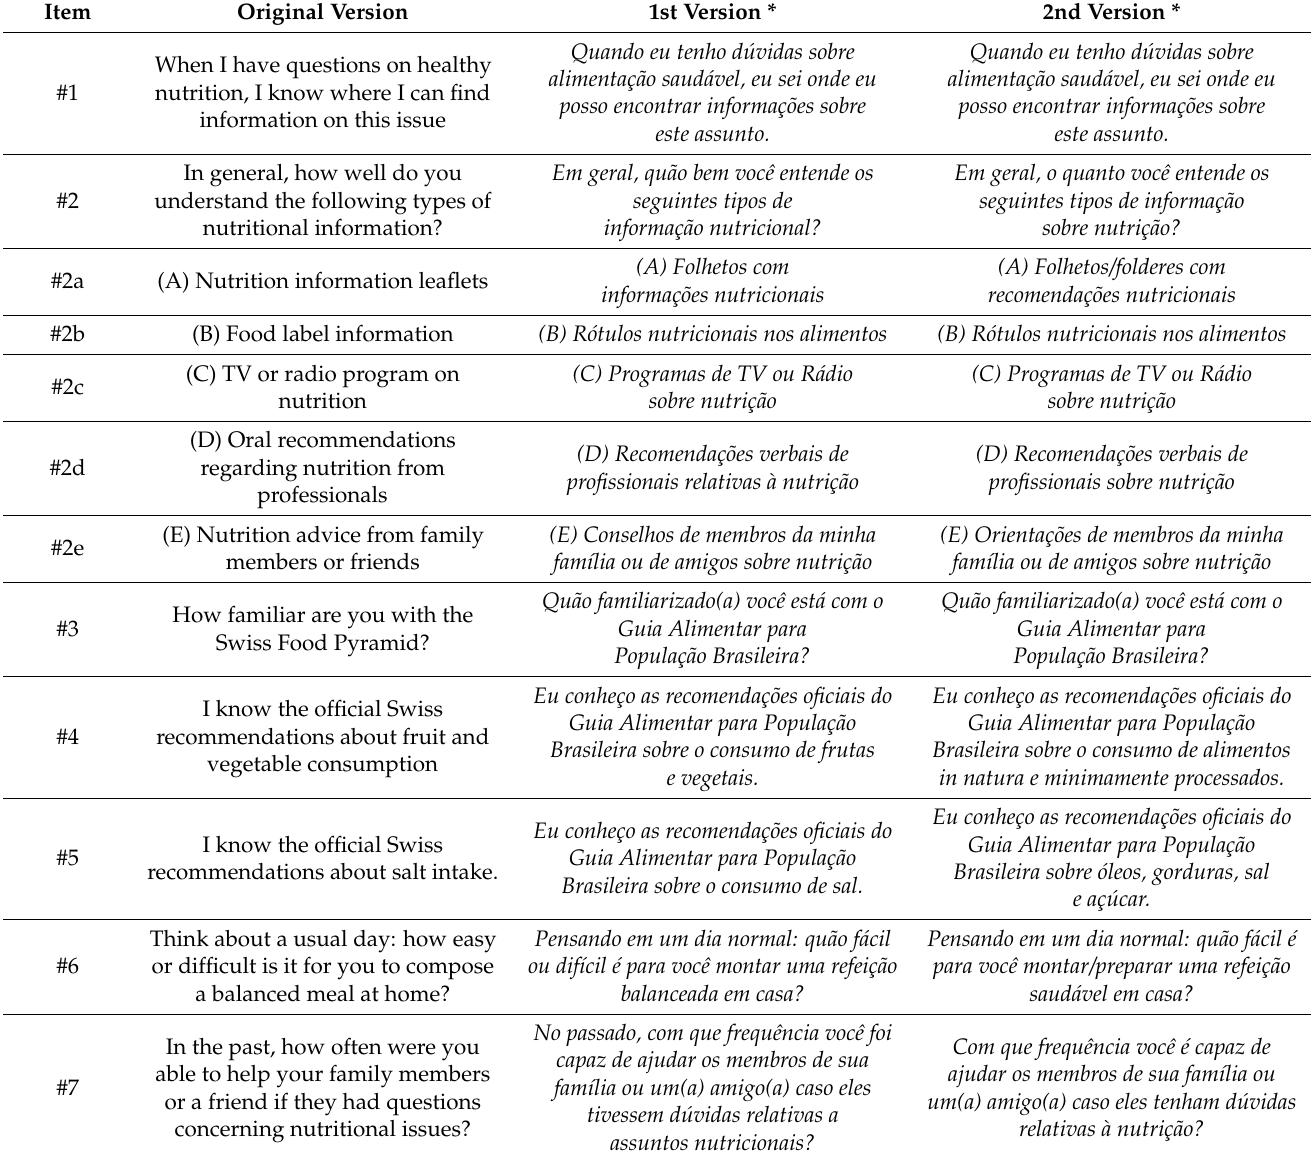
Table 1. Items of the original version of the SFLQ and the 1st version and 2nd version of the